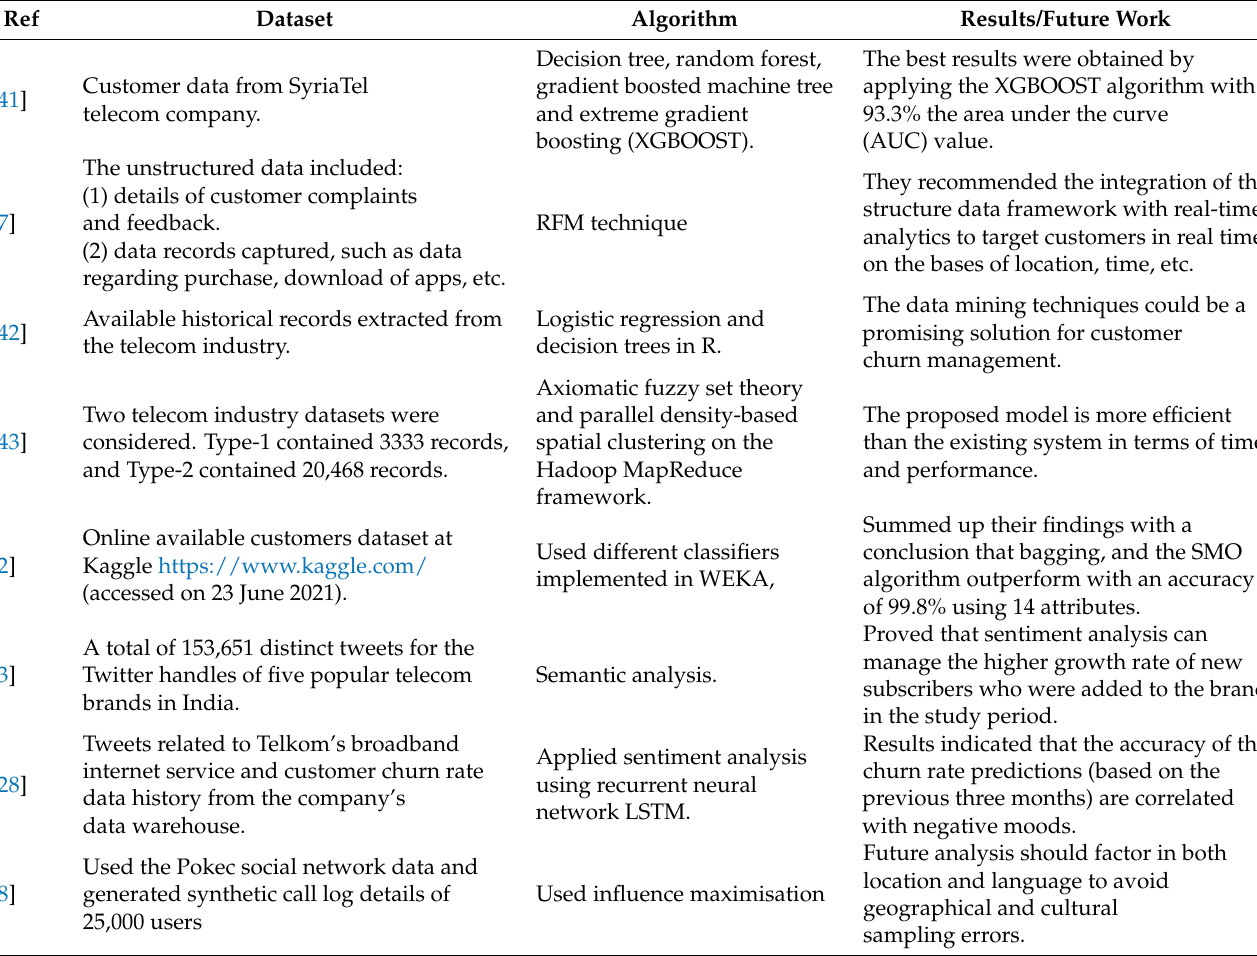
Table 1. Synthesis of the included studies related to customer churn and social media mining.